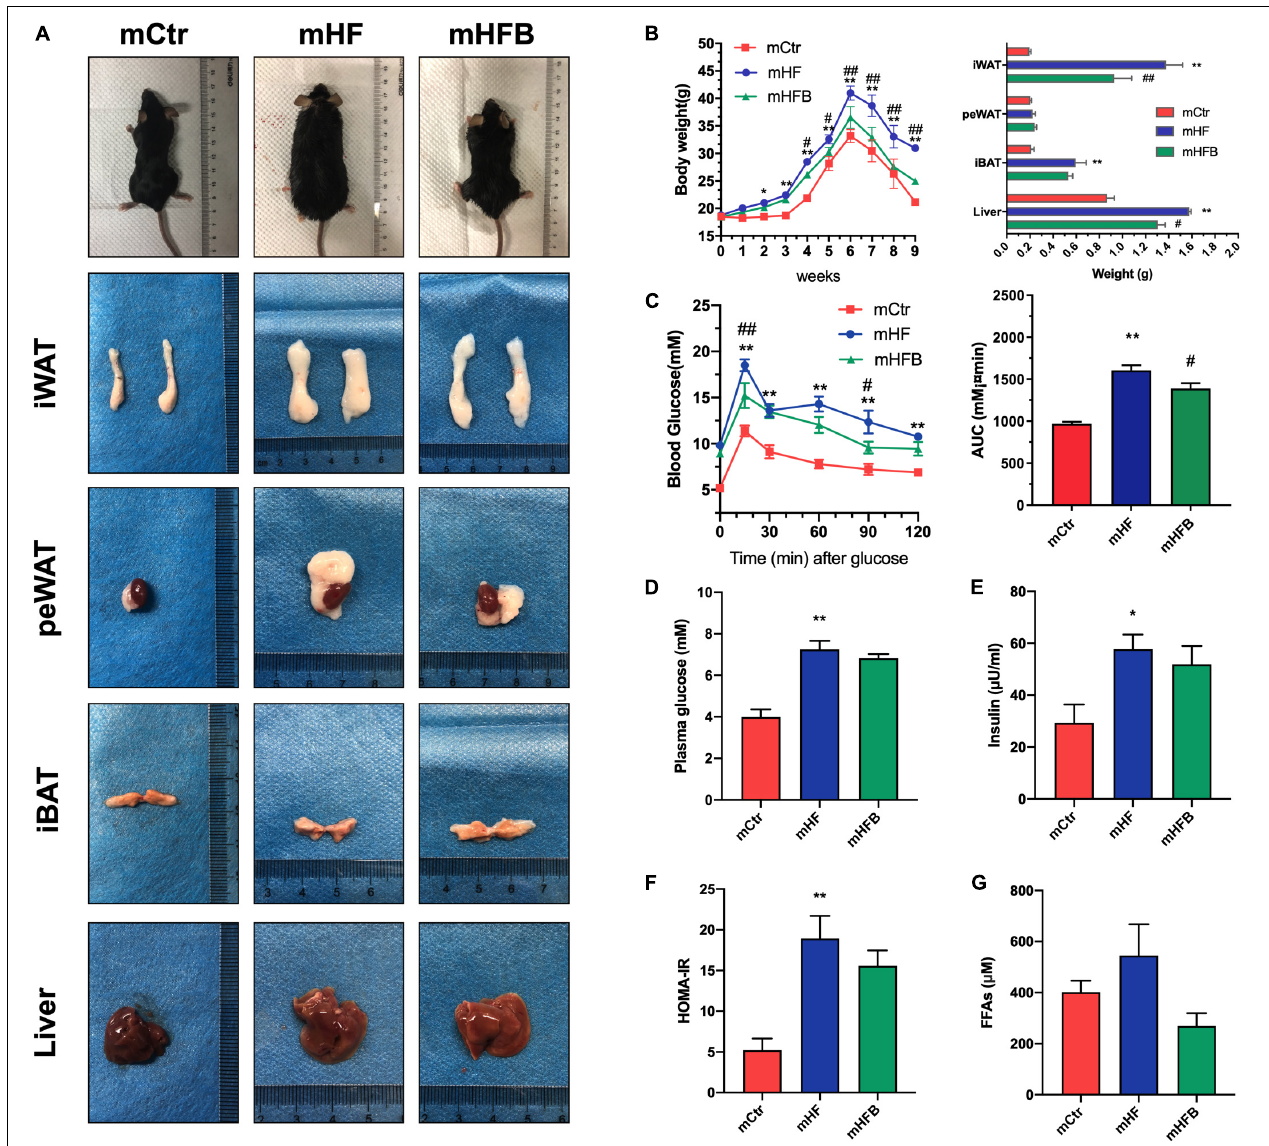
FIGURE 1 | Betaine improves glucose and lipid metabolism in high-fat diet dams. Dams were analyzed after weaning. (A) General picture of body composition; (B) body weight (left) and body composition (right) changes during the betaine treatment; (C) oral glucose tolerance test (left) and the area under the curve (right); (D) fasting plasma glucose; (E) fasting insulin level; (F) HOMA-IR; (G) FFAs. Ctr, standard control diet; HF, high-fat diet; HFB, high-fat diet with betaine; HOMA-IR, homeostasis model assessment of insulin resistance; FFAs, free fatty acids. Data are expressed as means ± S.E.M. ( n = 4–6/group). One-way and two-way ANOVA; * p < 0.05 and ** p < 0.01 vs. Ctr, # p < 0.05 and ## p < 0.01 vs.